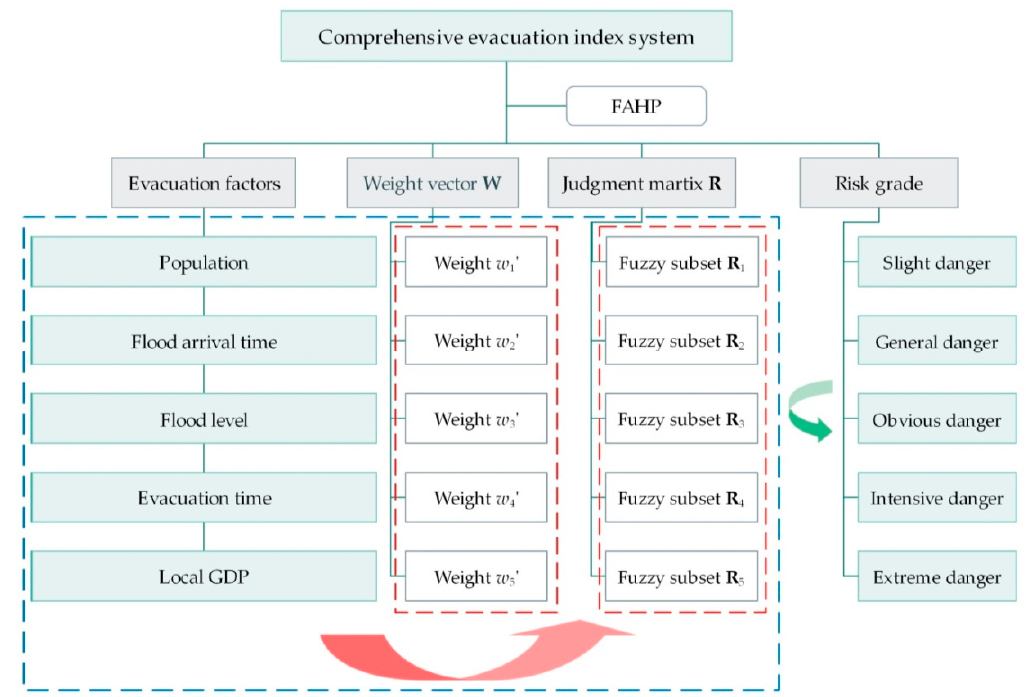
Figure 3. The comprehensive evaluation index system for the flood-affected areas.